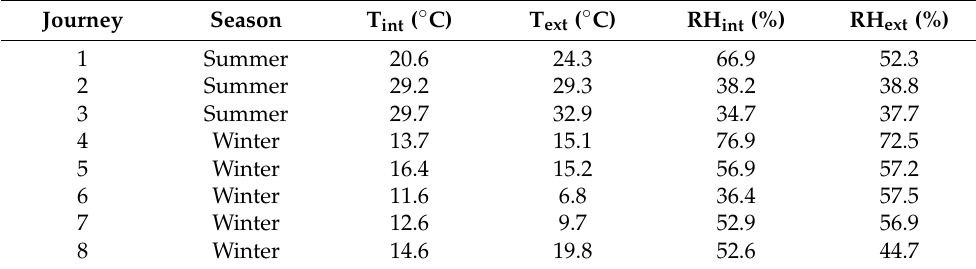
Table 1. Average temperature (T) and relative humidity (RH) inside (pig level) and outside the livestock vehicle during each pig transport journey from Spain to